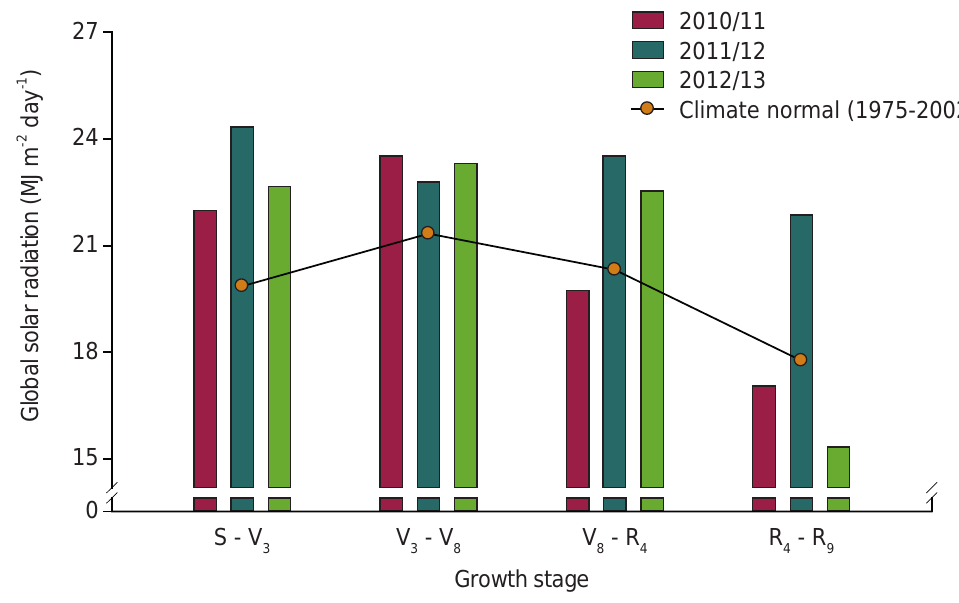
Figure 1. Global solar radiation at different rice growth stages and growing seasons and the climate normal (1975-2002) in Cachoeirinha, RS, Brazil. Source: Cargnelutti Filho et al. (2004) and Inmet (2013). S = sowing; V 3 = three fully-developed leaves on the main stem; V 8 = eight fully-developed leaves on the main stem; R 4 = anthesis; R 9 = harvest (Counce et al.,